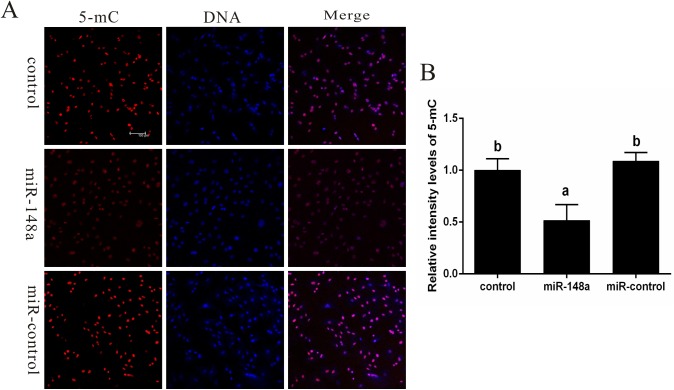
Effect of miR-148a on DNA methylation in PFFs.(A) Methylation patterns were determination on the basis of the relative levels of 5-methyl-cytosine (5-mC) in PFFs. Each sample was counter-stained with DAPI to visualize DNA. (B) Average optical intensity of global DNA methylation measured using Image-Pro Plus 6.0 software. Values are presented as mean ± SEM. Values with different superscript letters (a, b) within groups indicate significant difference (p < 0.05). Scare bar = 100μm.